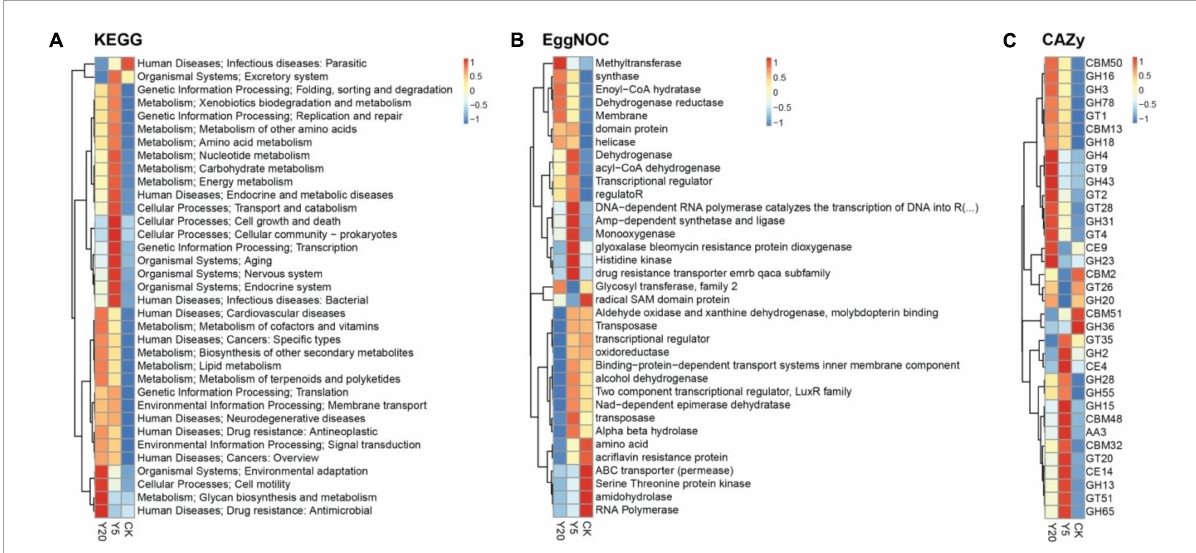
FIGURE4 A cluster heat map showing the abundance of the differential functions. The results of KEGG (A) , eggNOG (B) , and CAZy (C) are displayed from top to bottom: landscape for the treatment group, vertical right information for functional annotation, vertical left information for functional clustering tree, and the Z-values ( CK = 1-year monoculture orchard, Y5 = 5-year monoculture orchard, and Y20 = 20-year monoculture